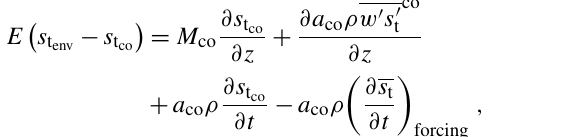
Table 1. Numerical configurations for the different experiments. (cid:49) x , (cid:49) y , and (cid:49) z are the x , y , and z grid spacings, respectively; L is the horizontal domain size; D is the domain height; T is the